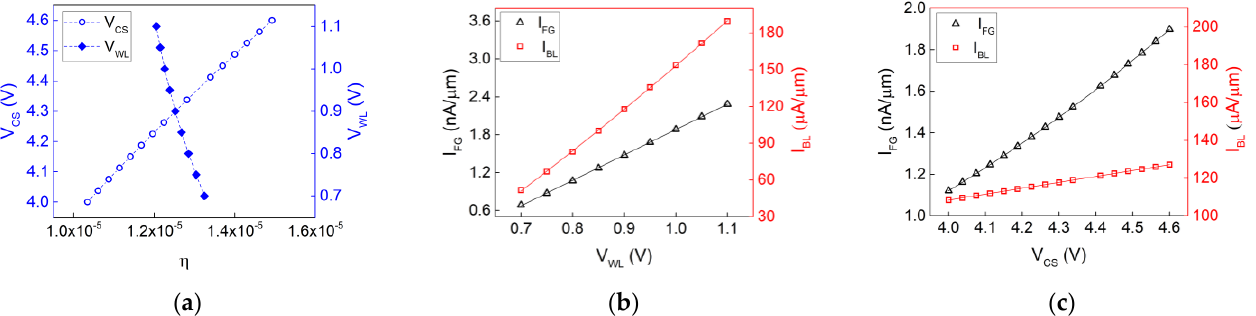
Figure 9. TCAD simulations of the overall impact of V CS and V WL on the main factors determining the injection efficiency: ( a ) η is drawn as a function of V CS (open symbols) and V WL (full symbols); ( b ) I FG (open triangles) and I BL (open squares) increase with V WL ; ( c ) I FG and I BL increase with V CS .